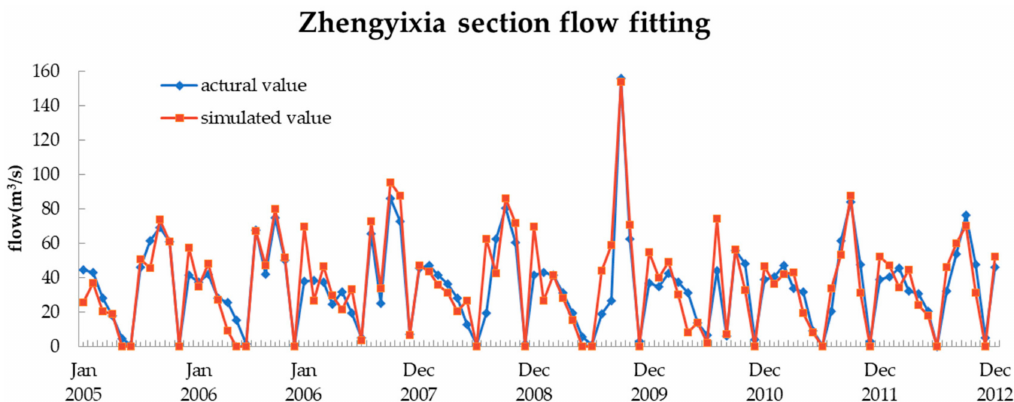
Figure 4. Flow fitting figure in the mainstream of Zhengyixia